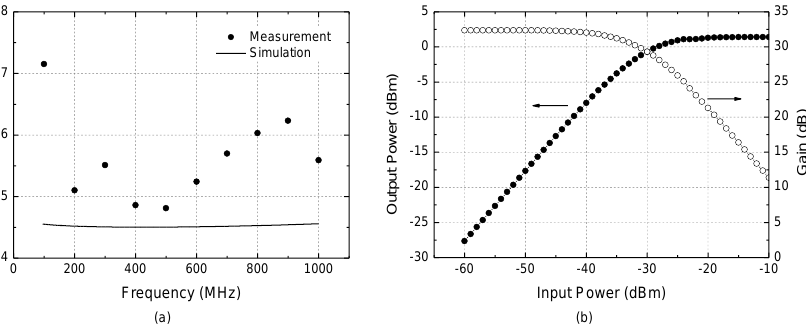
Figure 12. Measured results. ( a ) Noise figure; ( b ) Input-to-output power transfer characteristic.